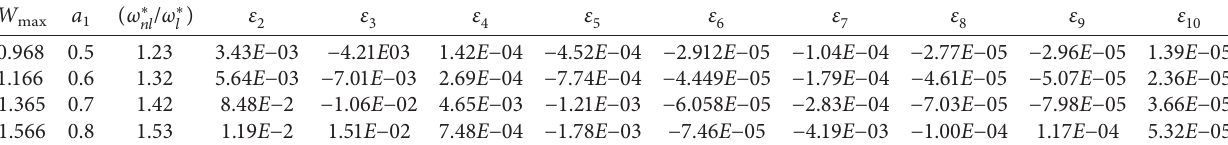
Table 1: The linear and nonlinear frequency ratio and the contribution coefficients of stepped beam (b) subjected to a free vibration. ) / ω ∗ W max a 1 ( ω ∗ nl l